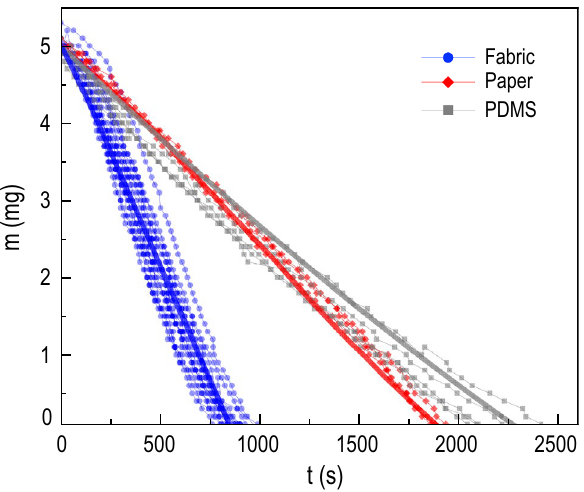
Figure 7. Evaporation dynamics predicted from the enhanced wetted area radius. The solid thick lines exhibit the estimated evaporation dynamics, and the thin lines with dots represent the experimental data for comparison.